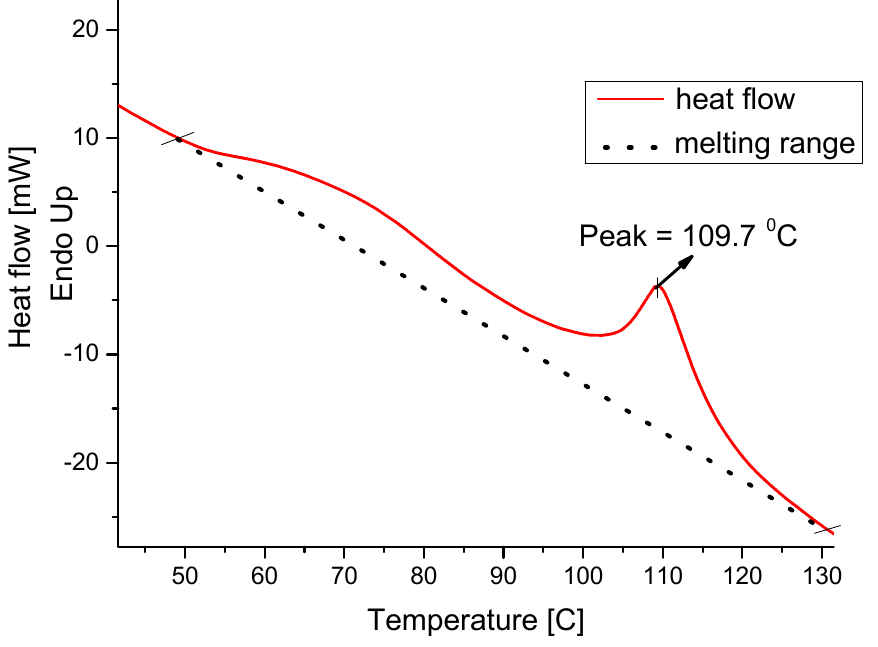
Figure 3. DSC curve for Wax3d